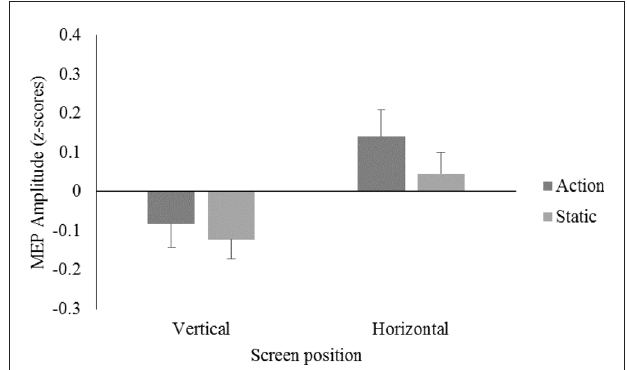
FIGURE 2 | Mean motor evoked potential (MEP) amplitudes displayed as z -scores, for the action and static conditions on the vertical and horizontal screen position for the right first dorsal interosseous (FDI)